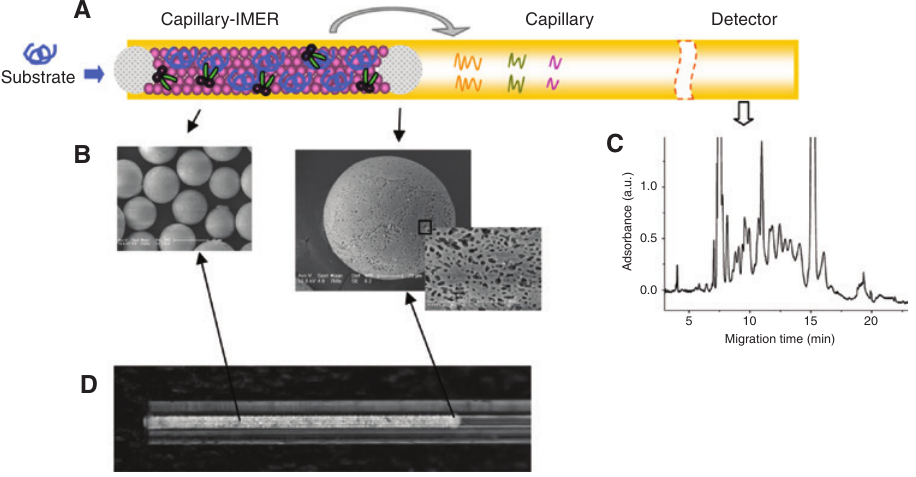
Figure 7: (A) Schematically drawing of the fabrication of the particle-packing CE-IMER and the online analysis of trypsin digestion. (B) SEM images of the trypsin beads and the perfusive silica single particle. (C) An example of the electropherogram of the tryptic peptides. (D) The real picture of the IMER taken by a